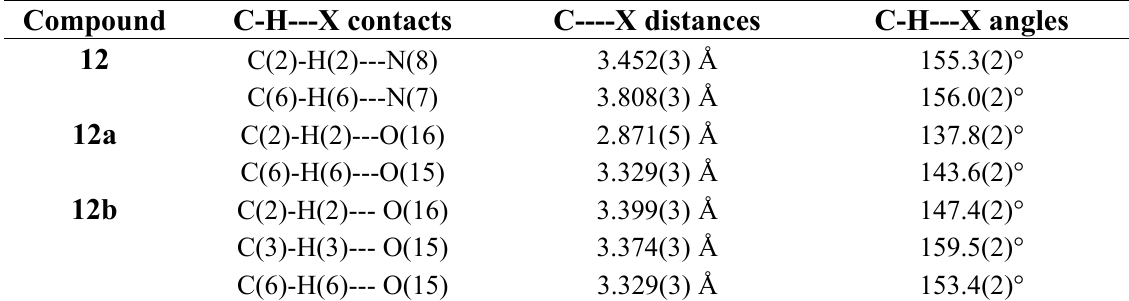
Table 3. Relevant intermolecular